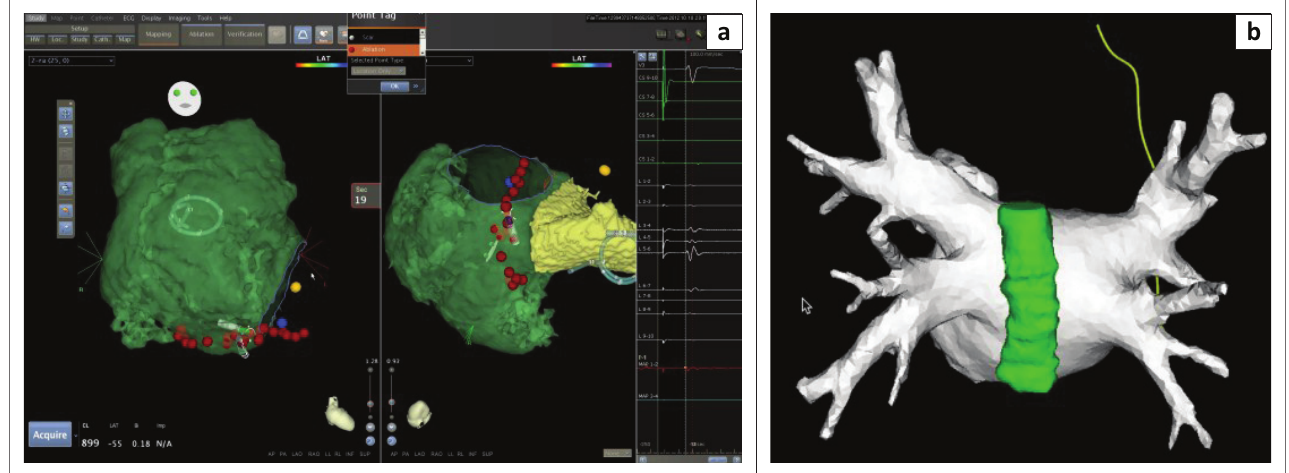
FIGURE 6: An ablation procedure guided by CT data: (a) The ablation catheter is visualised in real-time and ablation lesions are represented by red dots; (b) Besides the structure of the left atrium and pulmonary veins, surrounding structures such as the oesophagus (green) and phrenic nerve (yellow) can be used to guide ablation therapy.